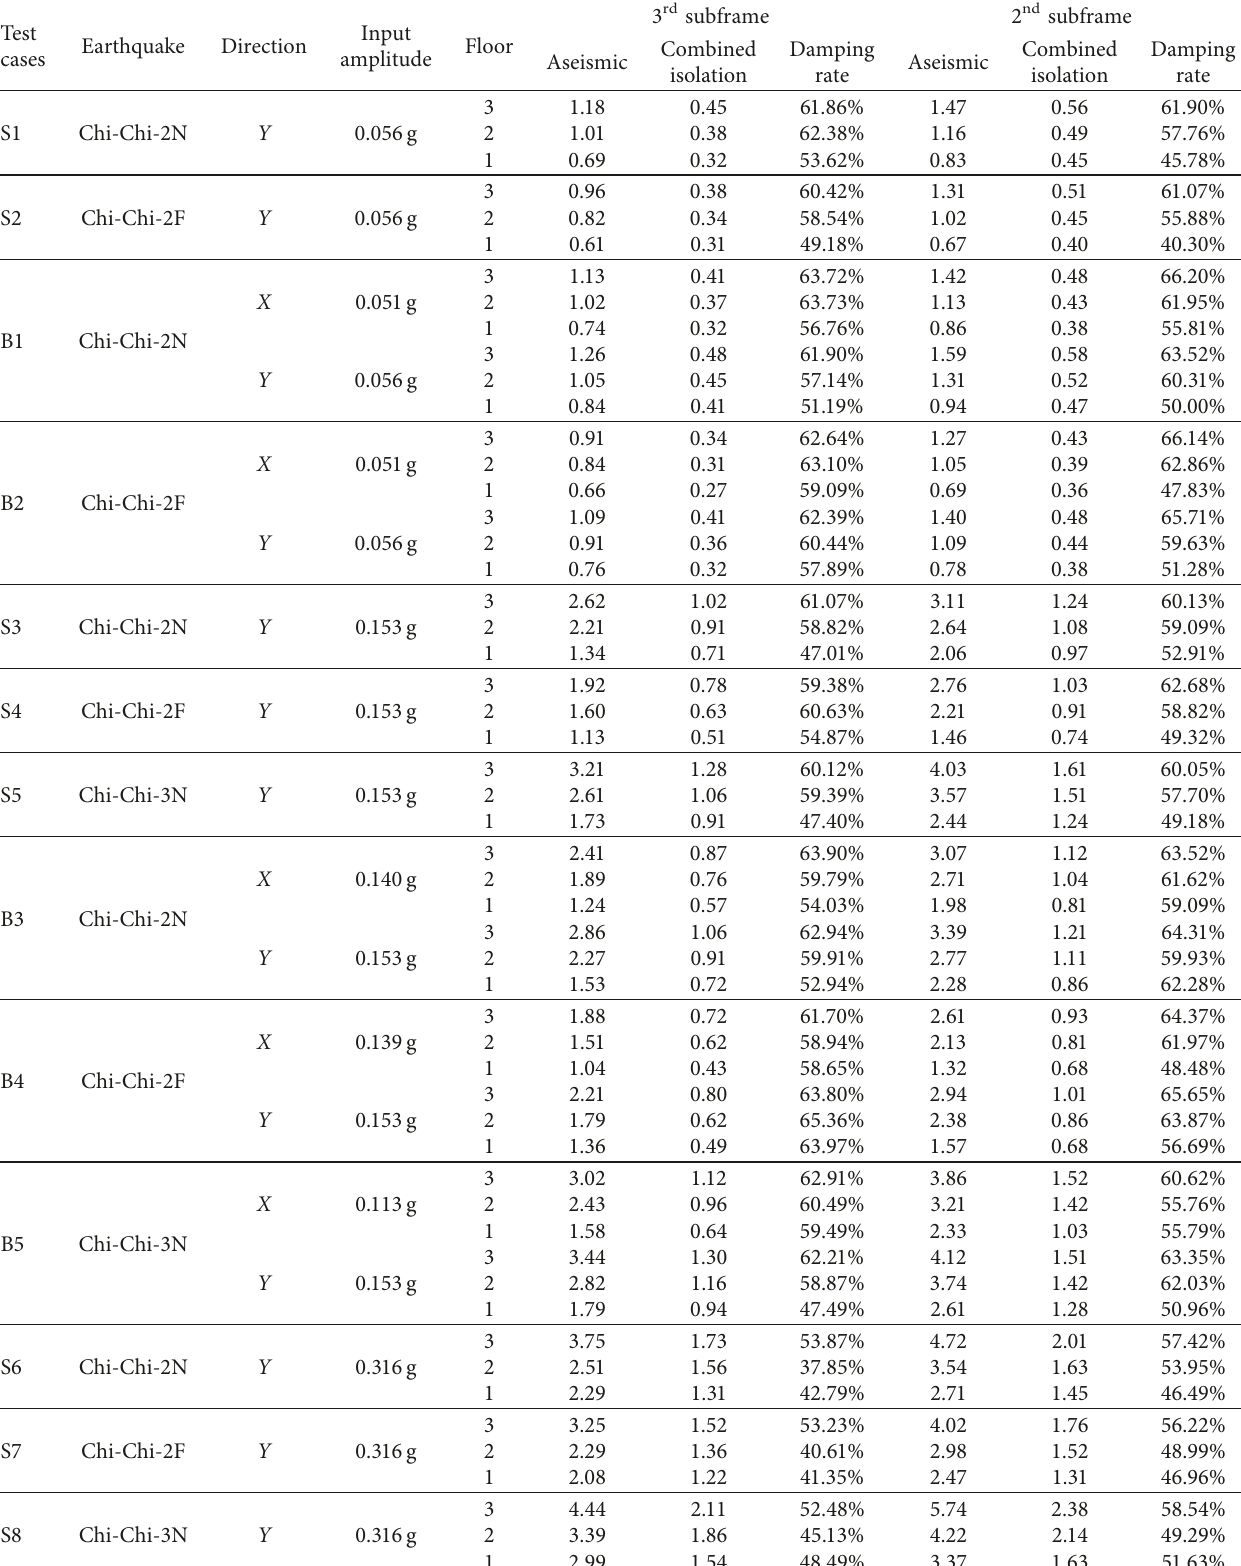
Table 4: Subframe acceleration response and damping rate (m/s 2